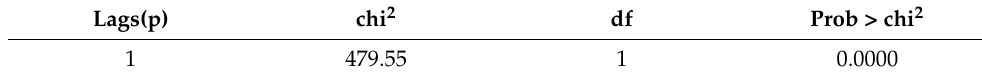
Table A1. Breusch-Godfrey LM test for autocorrelation ∆ CoVaR. Table A1. Breusch ‐ Godfrey LM test for autocorrelation Δ CoVaR.